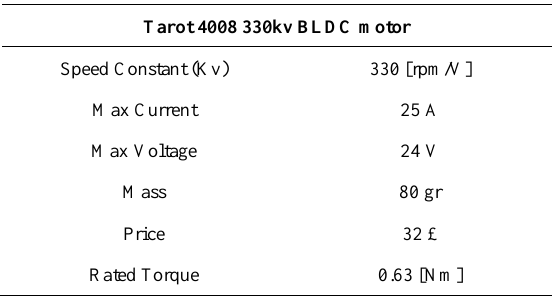
Table 1. Performance parameters of the BLDC motor